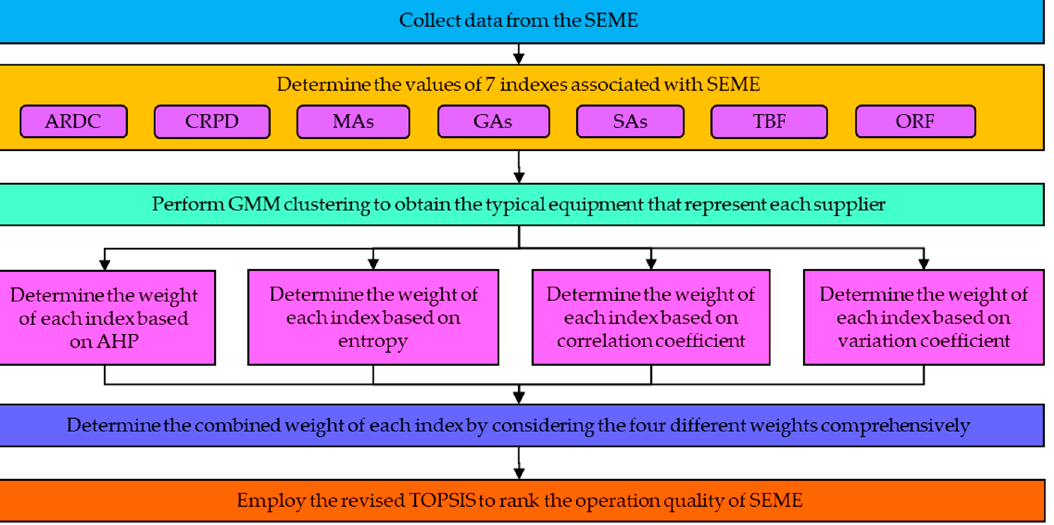
Figure 2. Flowchart of the proposed GMM, combination weight model and revised TOPSIS (GCT)-based algorithm.